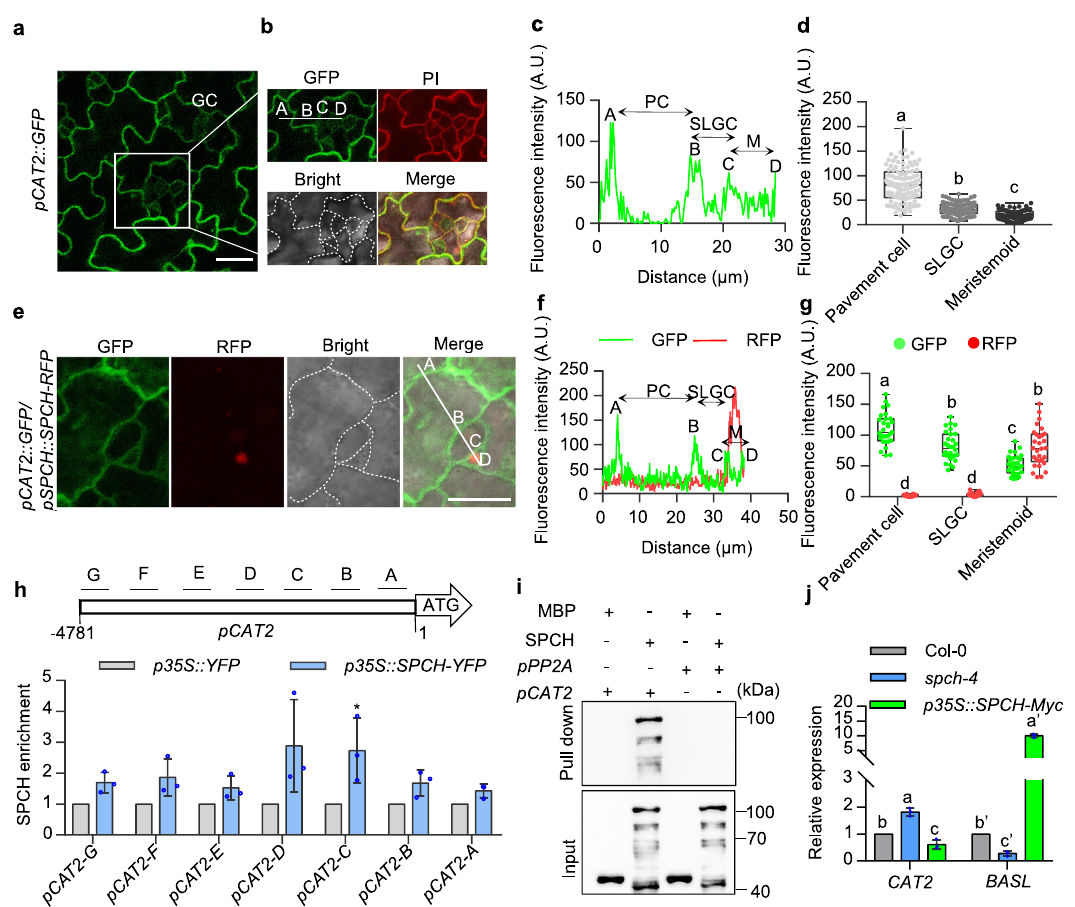
Fig. 3 | SPCH directly represses the expression of CAT2 . a – d The expression pattern of CAT2 in the cotyledon epidermal cells. Magni fi cations of the epidermal cells are shown in b . The pCAT2::GFP fl uorescent signals were in green, PI-marked celloutlineswereinred.Mergedimagesshowedthehigher CAT2 expressionlevels in the pavement cells and the lower levels in the smaller cells where cell division occurs. n =110 (Pavement), n =102 (SLGC) and n =102 (meristemoid) cells from 10 cotyledons were examined in d . e – g Co-localization of pCAT2::GFP and pSPCH::SPCH-RFP in cotyledon epidermal cells. n =30 (Pavement), n =30 (SLGC), and n =30 (meristemoid) cells were examined in g . h Quantitative ChIP-PCR showedthatSPCHbindsto CAT2 promoter.Seedlingsof p35S::YFP and p35S::SPCH- YFP were used to performed ChIP assays. The levels of SPCH binding were calcu- lated as the ratio between p35S::SPCH-YFP and p35S::YFP , and then normalized to that of control gene PP2A . Error bars indicate standard deviation (S.D.) (n=3 bio- logically independent samples). i SPCH directly binds to the promoter of CAT2 in vitro. MBP or MBP-SPCH were incubated with biotinylated DNA fragments from the PP2A and CAT2 promotersimmobilizedonstreptavidinbeads.The DNA-bound proteins were immunoblotted using anti-MBP antibody. j RT-qPCR analysis of the